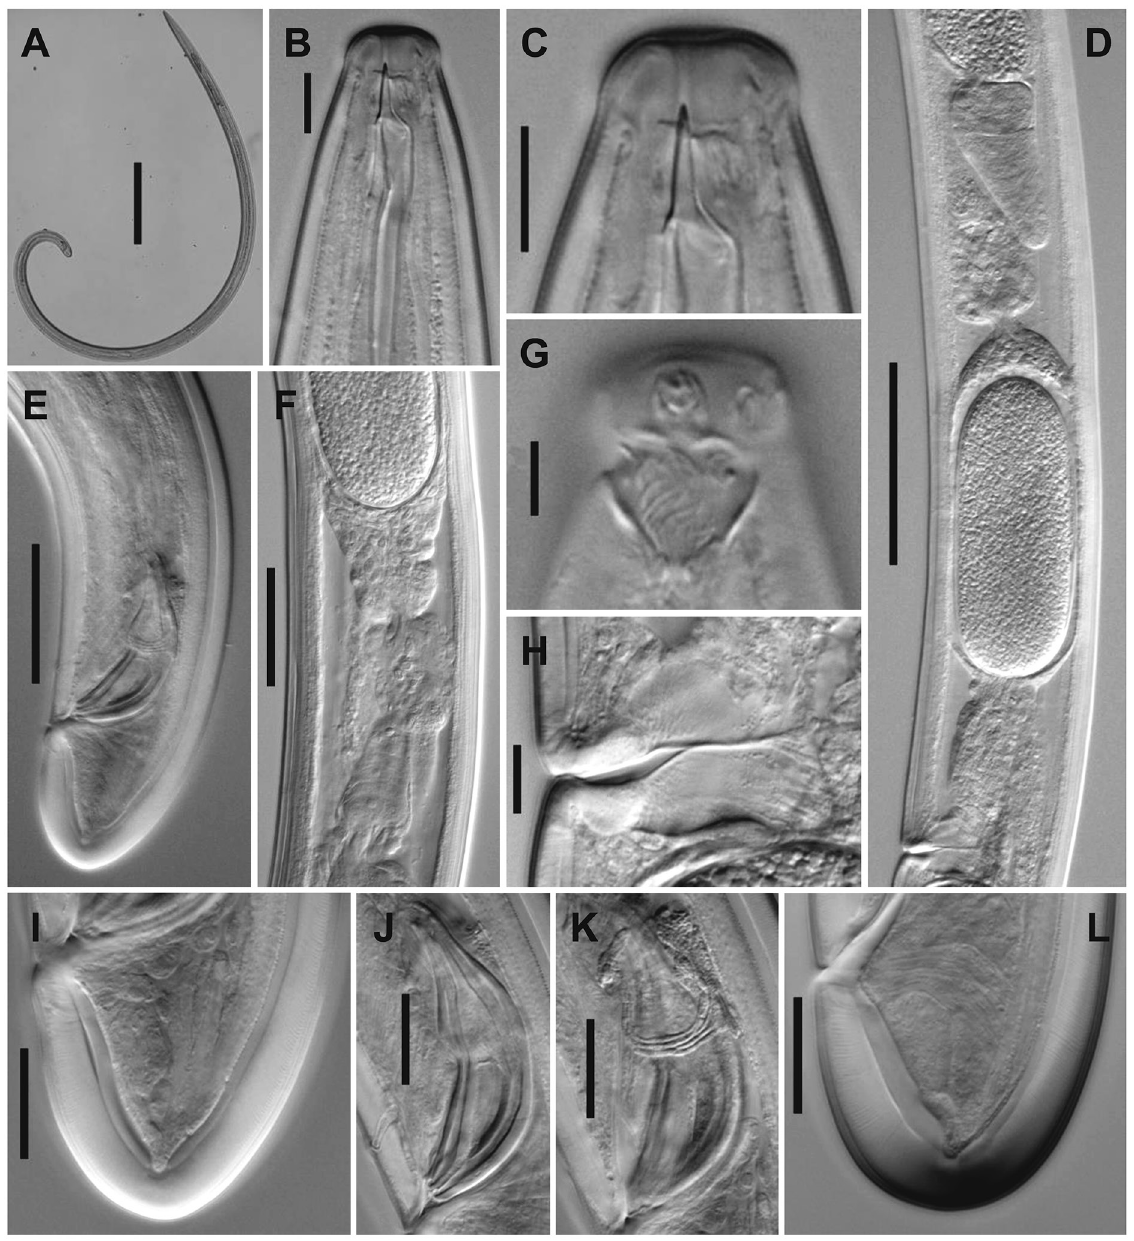
Fig. 8. Sectonema vietnamense sp. nov. (LM, type population). A . ♂, entire. B – C . Anterior region in lateral, median view. D . ♀, anterior genital branch. E . ♂, posterior body region. F . Oviduct-uterus junction. G . Lip region in lateral, surface view. H . Vagina. I . ♂, caudal region. J – K . Spicules. L . ♀, caudal region. Scale bars: A = 500 μm; B–C, H = 10 μm; D = 100 μm; E–F = 50 μm; G = 5 μm; I–L = 20